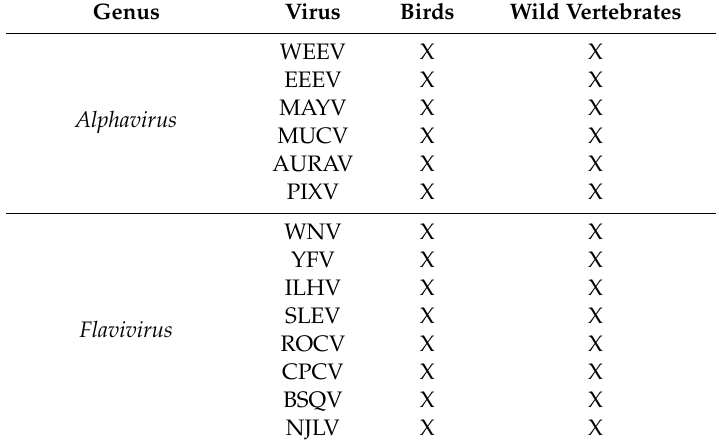
Table A1. The antigenic panel used for wild vertebrates selected for the study and tested for Hemagglutination Inhibition (HI)